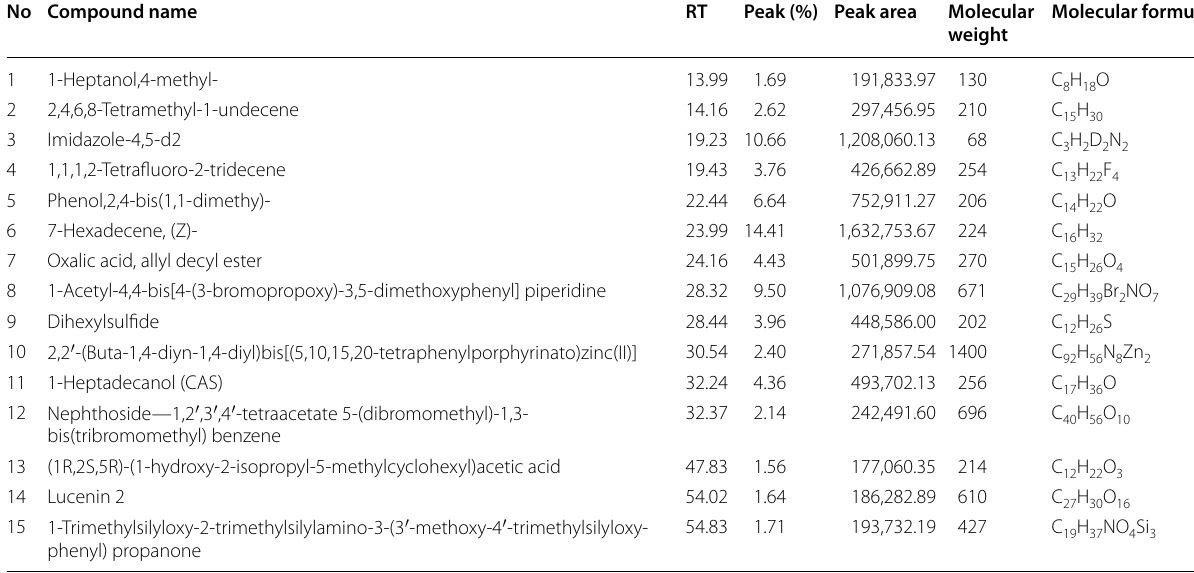
Table 2 Chemical composition of the methanolic extract of S. mahagoni leaves